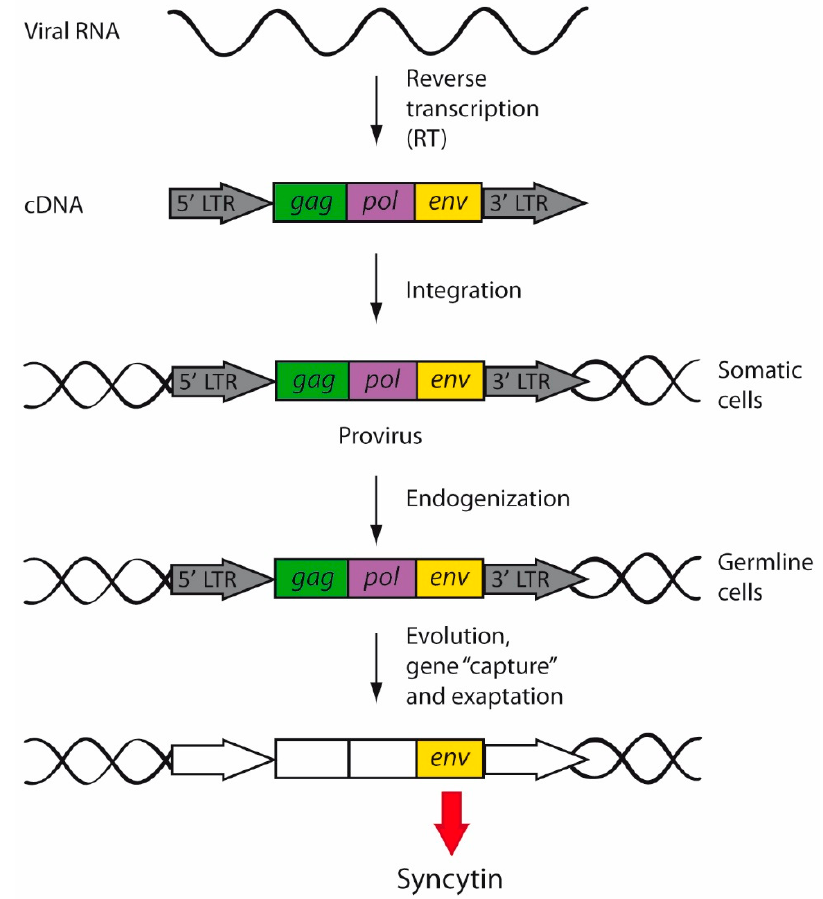
Figure 3. Retrovirus endogenization and exaptation. During replication, retroviral RNA is reverse- transcribed, giving rise to a double-stranded cDNA provirus that will be then integrated into the cellular genome of somatic cells. However, when the exogenous retroviruses infected germline cells, the integrated retroviruses began to be inherited in a Mendelian fashion. Endogenized retroviruses were vertically transmitted and fixed into the human genome. Over the course of evolution, endogenous retroviruses accumulated mutations (white boxes) and underwent gene capture and exaptation, by which retroviral genes started to perform new physiological functions. For example, syncytins are env genes of retroviral origin captured by mammals.